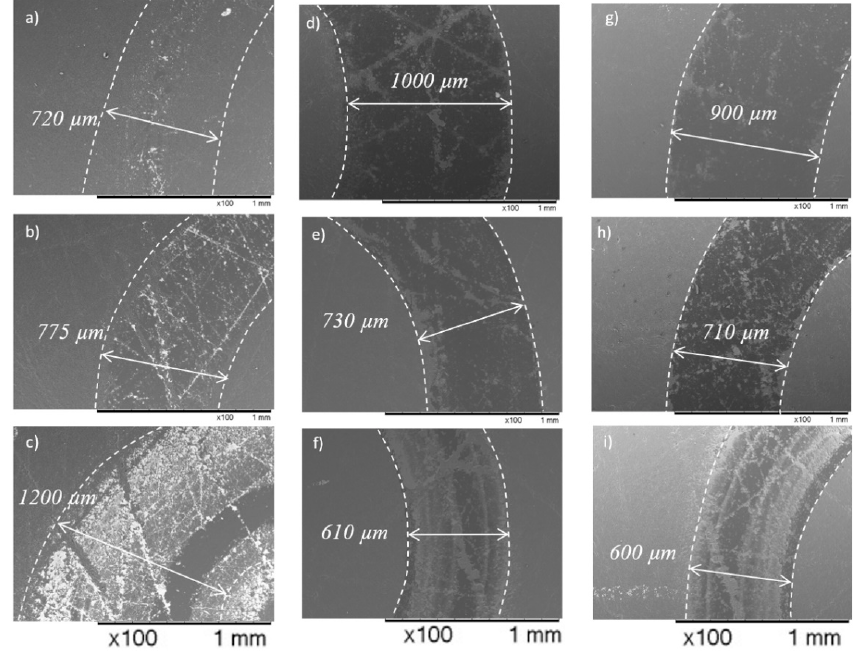
Figure 7. SEM images of the wear scars after sliding tests on the NCD film at ( a ) RT, ( b ) 300 °C and ( c ) 450 °C; Al 2 O 3 /NCD film at ( d ) RT, ( e ) 300 °C and ( f ) 450 °C; and A-Al 2 O 3 /NCD film at ( g ) RT, ( h ) 300 °C and ( i ) 450 °C.